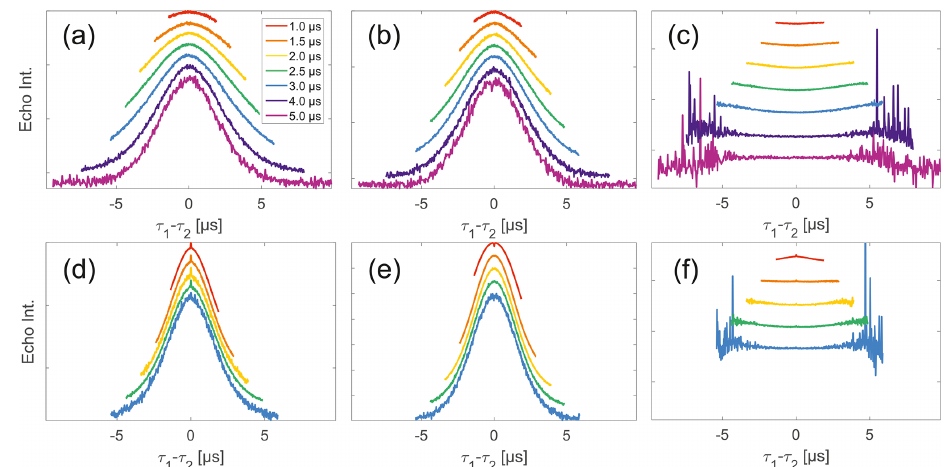
Figure 4. Analysis of data from SIFTER and SIDRE at various trace lengths on 50µM monoradicals in OTP. Panels (a) – (c) show data of nitroxide monoradical (1); (d) – (f) show data of trityl monoradical (2). The recorded traces of SIFTER (a, d) and SIDRE (b, e) are shown. The remaining panels (c, f) show the result from division of SIFTER by the corresponding SIDRE trace. Traces in (c) and (f) are displayed in stack plots at arbitrary offset.